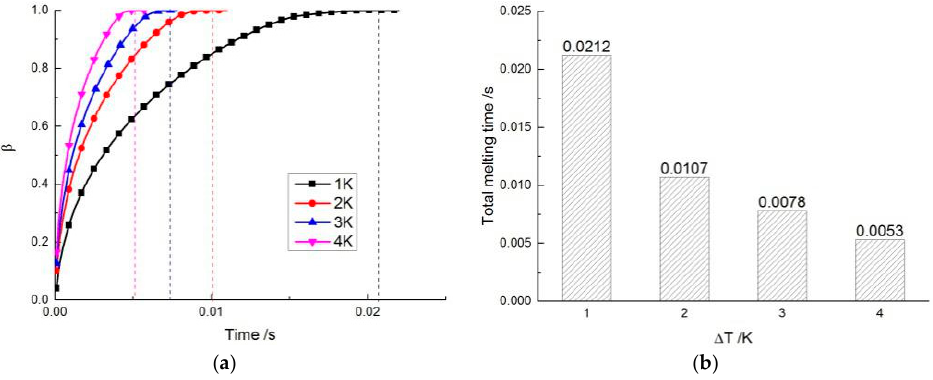
Figure 4. Melting process at different wall temperatures. ( a ) Melting process; ( b ) Total melting time.